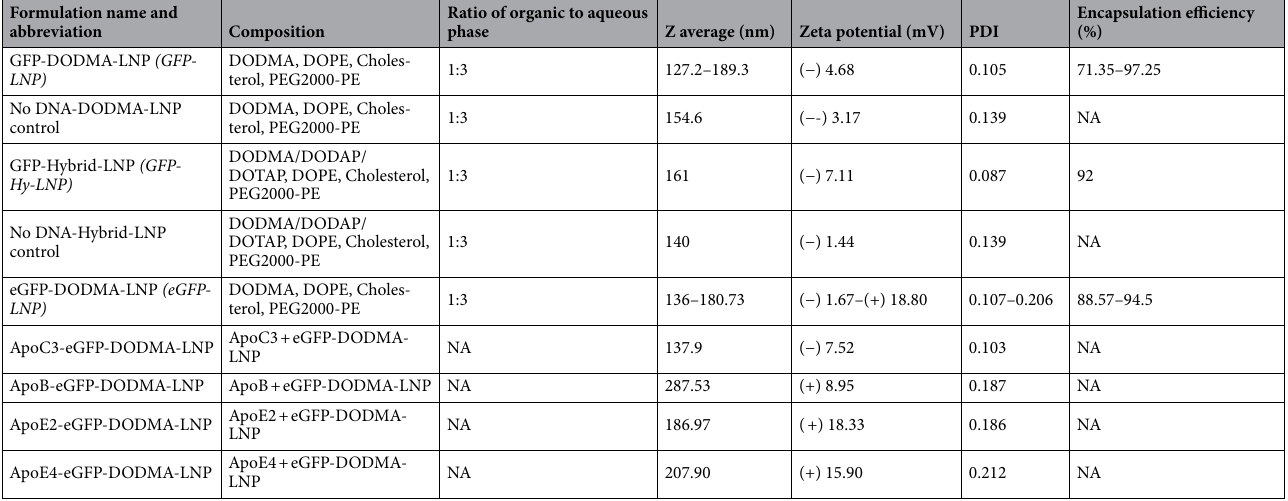
Table 2. Physicochemical properties of LNPs and Apo-LNP